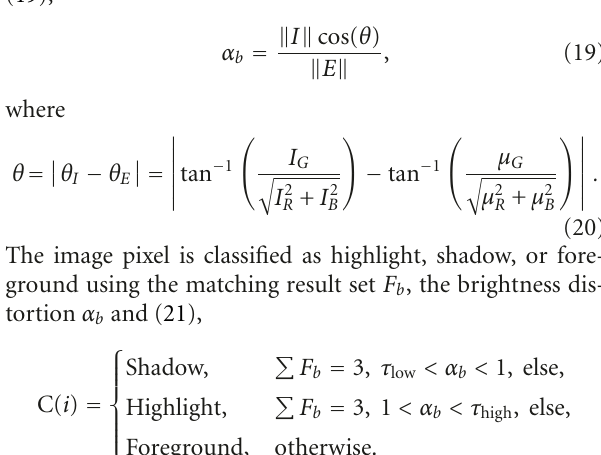
Figure 4: The proposed 3D cone model in the RGB color space.